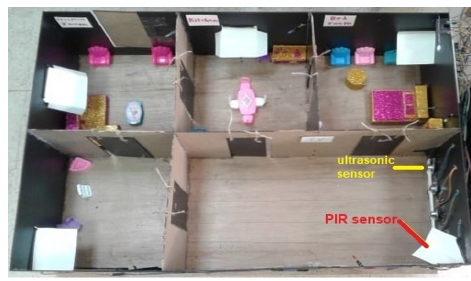
Figure 6. Prototype